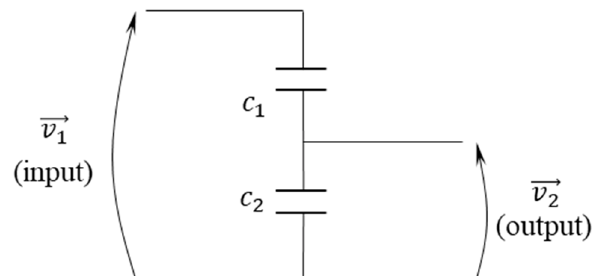
Figure 1. Low-power voltage transformers (LPVT) electric equivalent circuit.